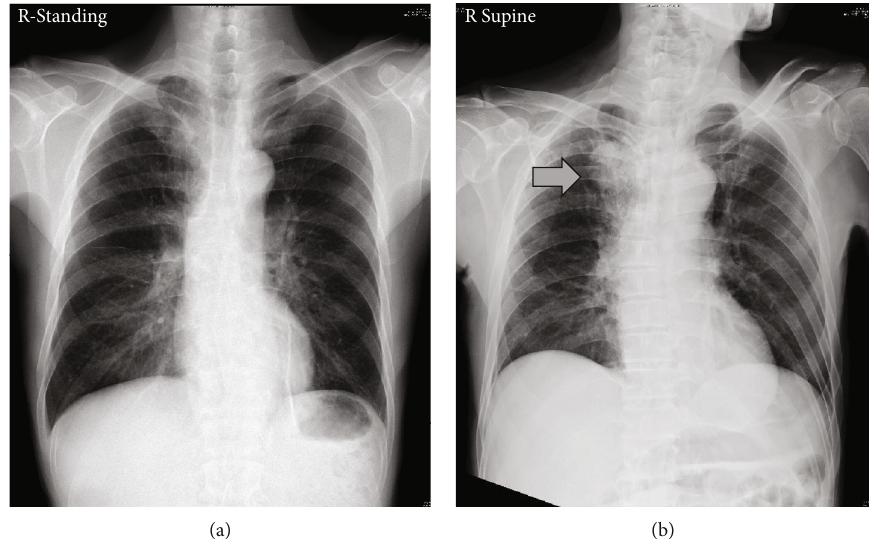
Figure 1: Unremarkable chest X-ray at (a) mania onset and (b) 2 years later, with a mass (arrow) in the right upper lobe of the lung.